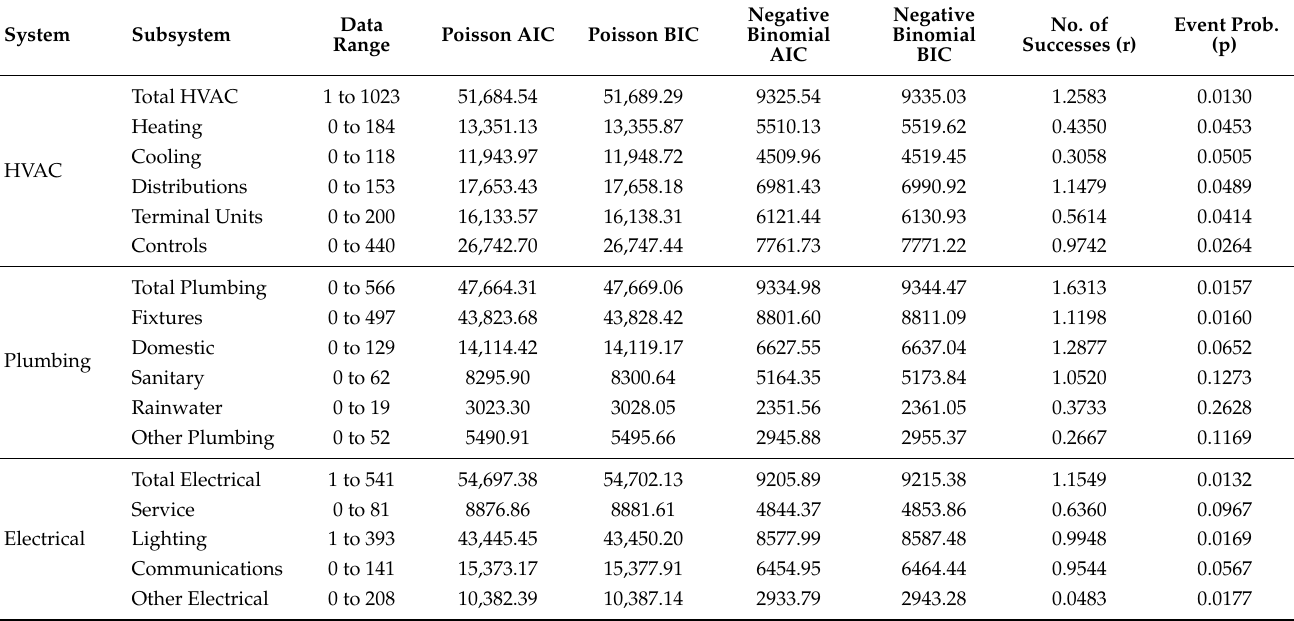
Table 5. Goodness-of-fit of distributions for systems and